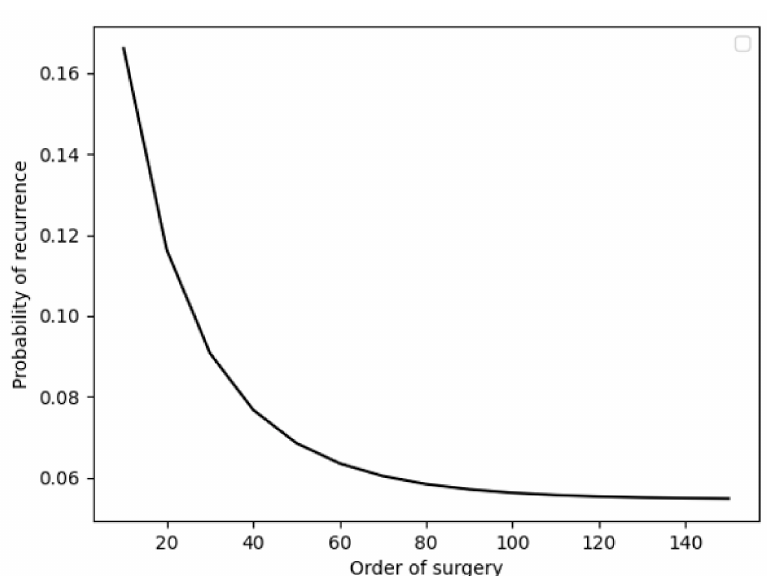
Figure A3. Constructed model showing the probability of recurrence given the order of surgery for a median tumor size of 21 mm (median in sample) for the model using the three hospitals with > 100